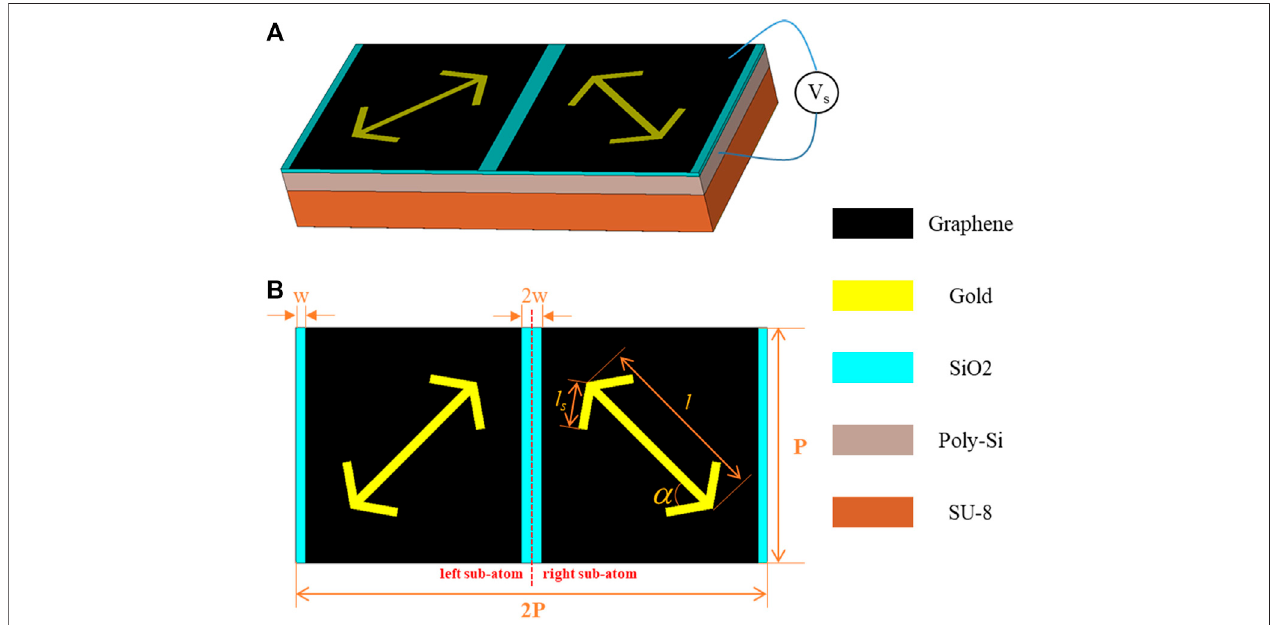
FIGURE 1 | (A) The 3D schematic diagram of the meta-atom. (B) The main view of the meta-atom, where l = 180 μ m, l s = 50 μ m, α = 55 ° , w = 10 μ m, and p = 250 µm. The red dash line divide the meta-atom into two sub-atoms.